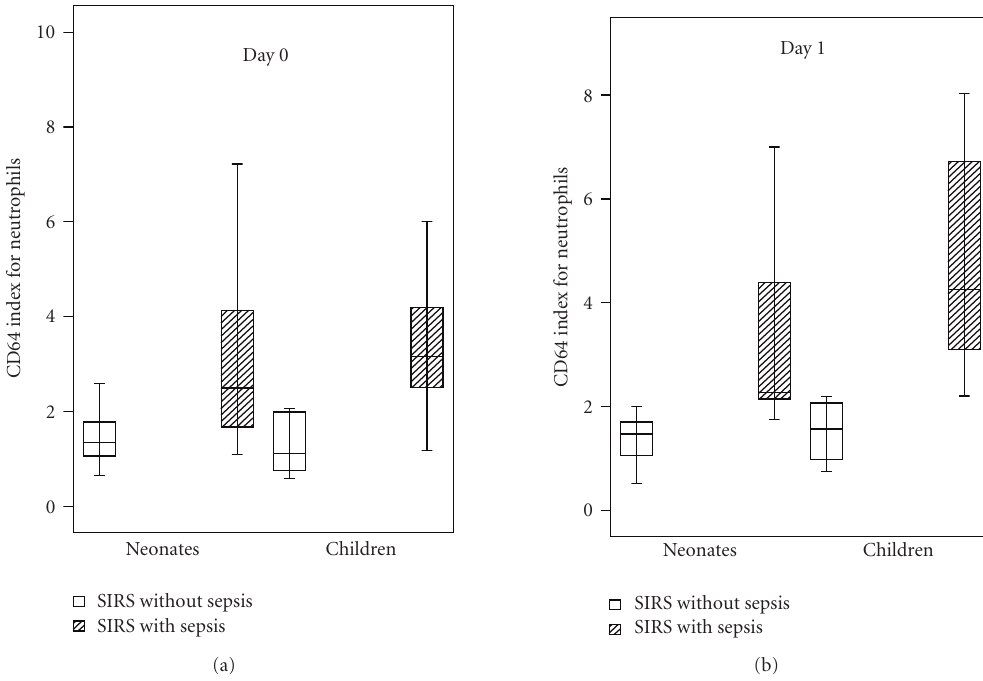
Figure 2: CD64 indexes for neutrophils at the time of suspected sepsis (day 0), and 24 hours later (day 1), for separate groups of neonates and children. Data are presented as box plots (median value and interquartile range). Outliers and extreme cases of index CD64 are not shown.